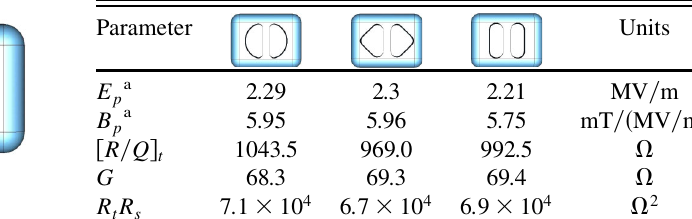
FIG. 12. Parallel-bar cavity designs with different cross sections